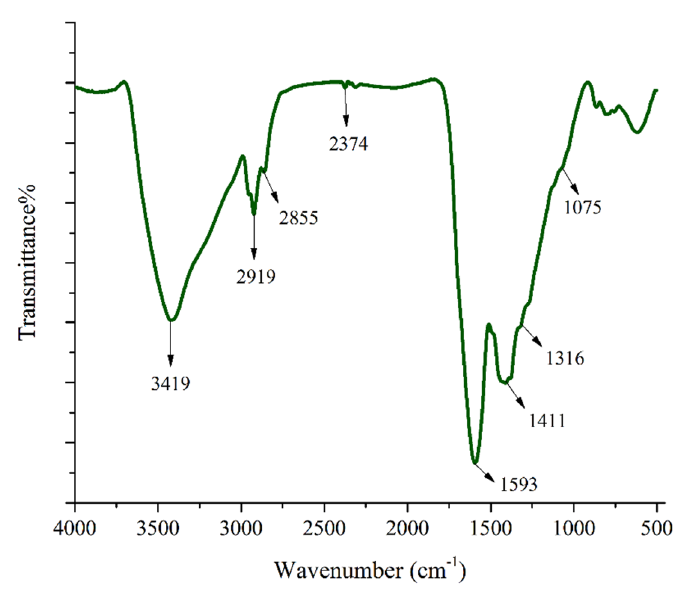
Figure 2. The FT-IR spectrum of PG-AC5 nanomaterial.